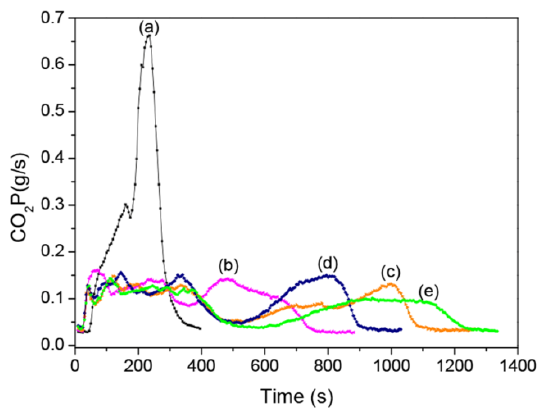
Figure 8. Production rate of CO 2 (CO 2 P) curves of EVA and composites. ( a ) EVA; ( b ) ELDH - 0; ( c ) ELDH - Ni; ( d ) ELDH - Co; and ( e ) ELDH - Cu.